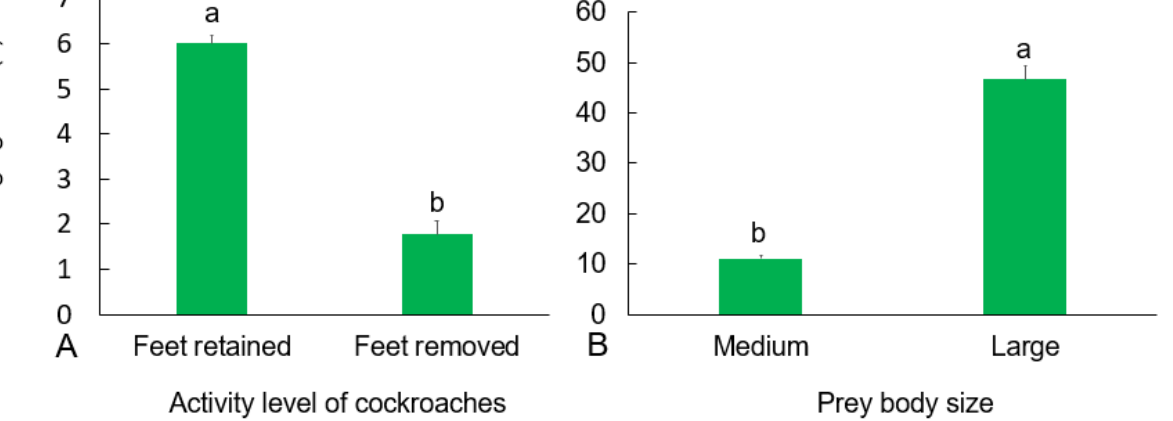
Figure 5. The effect of feet removal ( A ) and size ( B ) of cockroaches on the stinging time of H. venator allocated to a single cockroach in the field. Bars with the same letter are not significantly different at the 0.05 level (Kruskal–Wallis test).